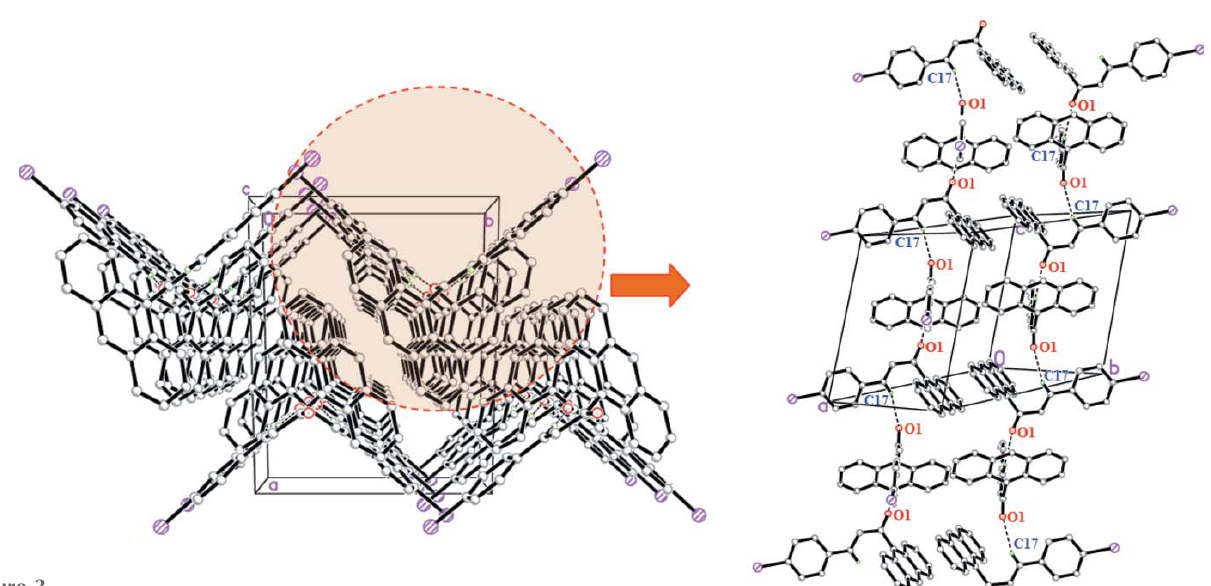
Figure 3 The crystal packing of compound (II) showing weak C—H (cid:4)(cid:4)(cid:4) O interactions.